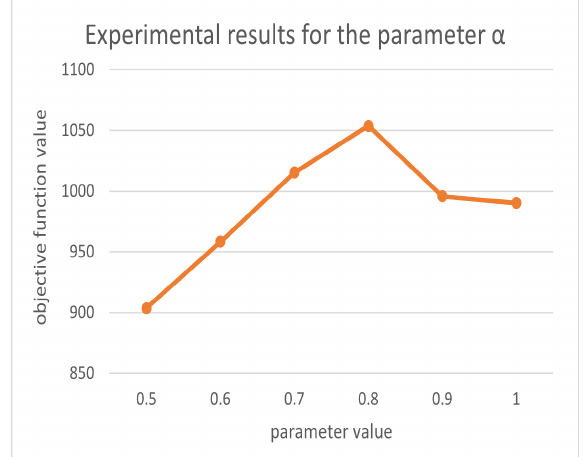
Figure 6. Experimental results for parameter α .